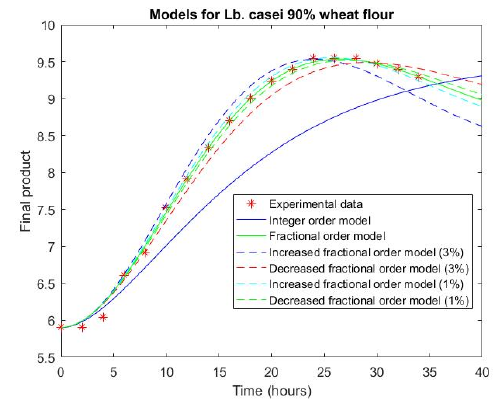
Figure 6. Comparison between simulated and experimental data for experiment 3 using L. casei .